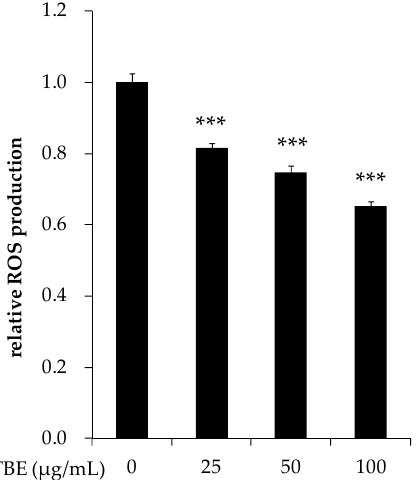
Figure 7. Effect of TBE on reactive oxygen species (ROS) production in macrophages. THP-1 macrophages were incubated with 25–100 μ g/mL TBE for 2 h, and then intracellular ROS levels were measured by using 2 ′ ,7 ′ -dichlorofluorescein-diacetate (DCFH-DA) (excitation 485 nm/emission 528 nm). Values are means ± SD ( n = 3). *** p < 0.001, compared to untreated control group.